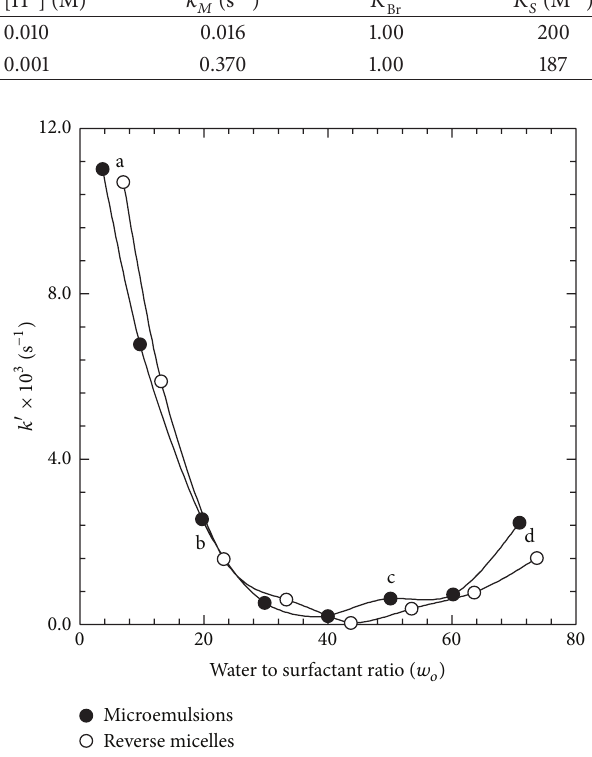
Figure 2: The 𝑘 󸀠 versus 𝑤 𝑜 profiles for the acid hydrolysis of 2.21 × 10 −5 MBz in CTAB/1-butanol/cyclohexane/water microemulsions and CTAB/1-butanol/water reverse micelles at [H + ] = 0.001